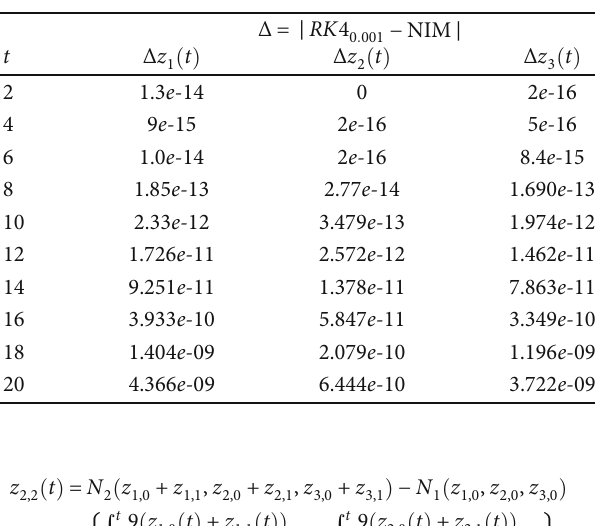
Table 6: Di ff erences between 9-iteration NIM with RK4 solutions in the sinusoidal input